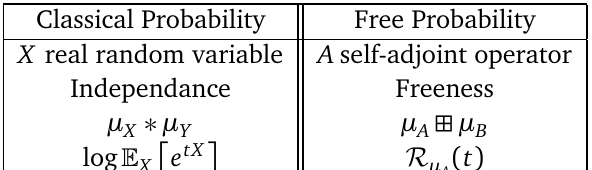
Table 1: Correspondence between the classical and the free world Classical Probability Free